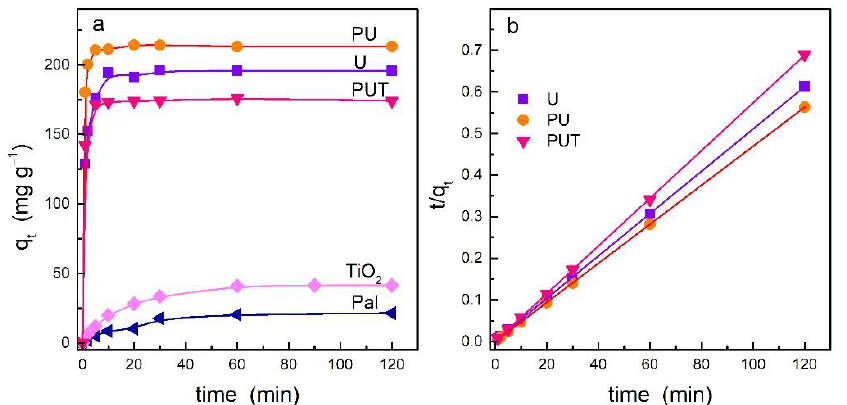
Figure 5. Time dependence of MO adsorption on the pure Pal, TiO 2 , and UiO-66 and the prepared composites (PU and PUT) ( a ). Pseudo-second-order rate law for MO adsorption on materials containing UiO-66 ( b ). Experimental conditions: 90 mg·L −1 initial MO concentration, 0.4 g·L −1 of the adsorbent, pH = 5, volume = 50 mL, and T = 25 °C. Table 1. Experimentally obtained and calculated values for q e , removal efficiency (RE %), and cor- relation coefficient ( R 2 ) for the pseudo-second-order kinetic model used to simulate the adsorption process and photocatalytic rate constant (k).